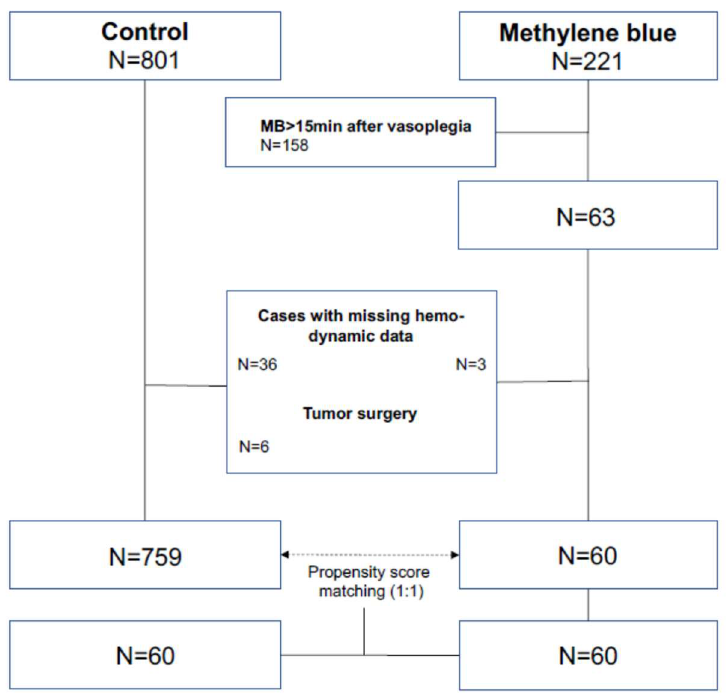
Figure 1. Study population. Table 1. Baseline demographics of the methylene blue group compared to control group and propen- sity score-matched control